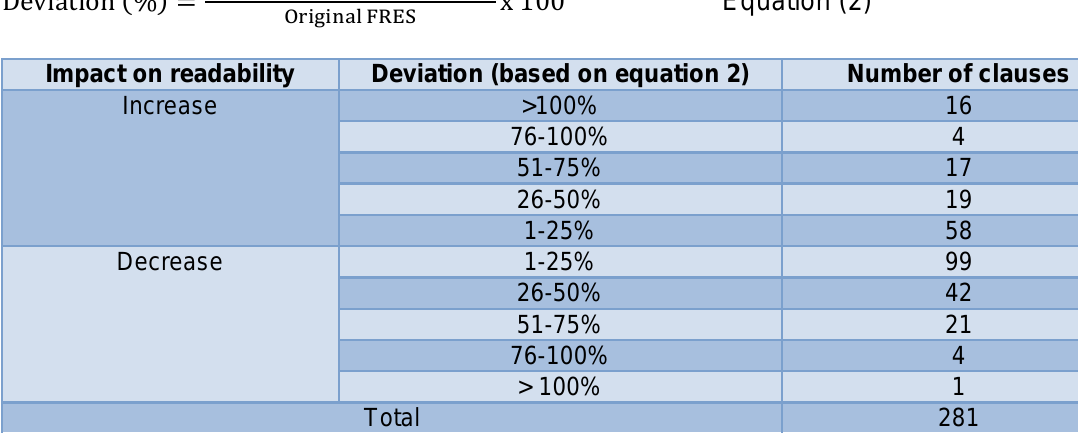
Table 3 Impact of modifications on readability